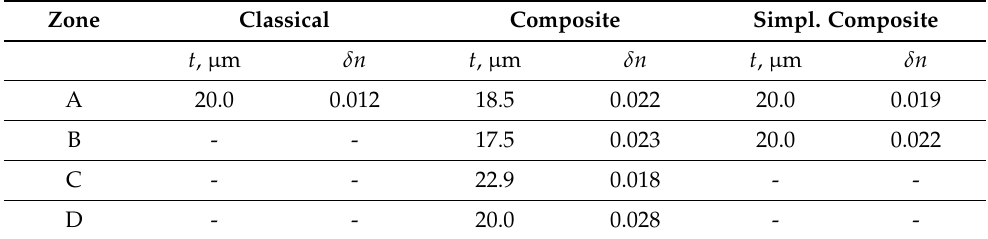
Table 4. Optimized parameters of the hologram structure.